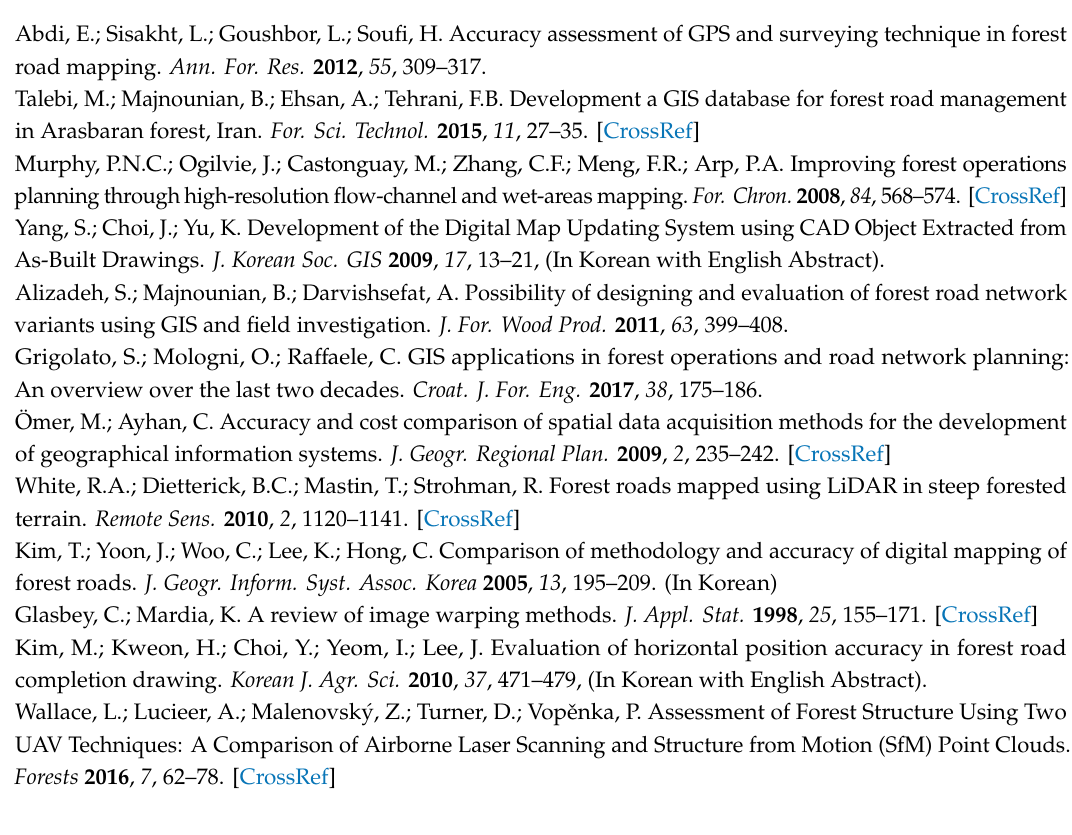
mapping techniques and the reference map on Seosan: (a) GNSS mapping, (b) as-built drawing, and (c) image warping, Figure S7: Example of turning function analysis between the three mapping techniques and the reference map on Cheonan: (a) GNSS mapping, (b) as-built drawing, and (c) image warping, Figure S8: Example of turning function analysis between the three mapping techniques and the reference map on Gongju: (a) GNSS mapping, (b) as-built drawing, and (c) image